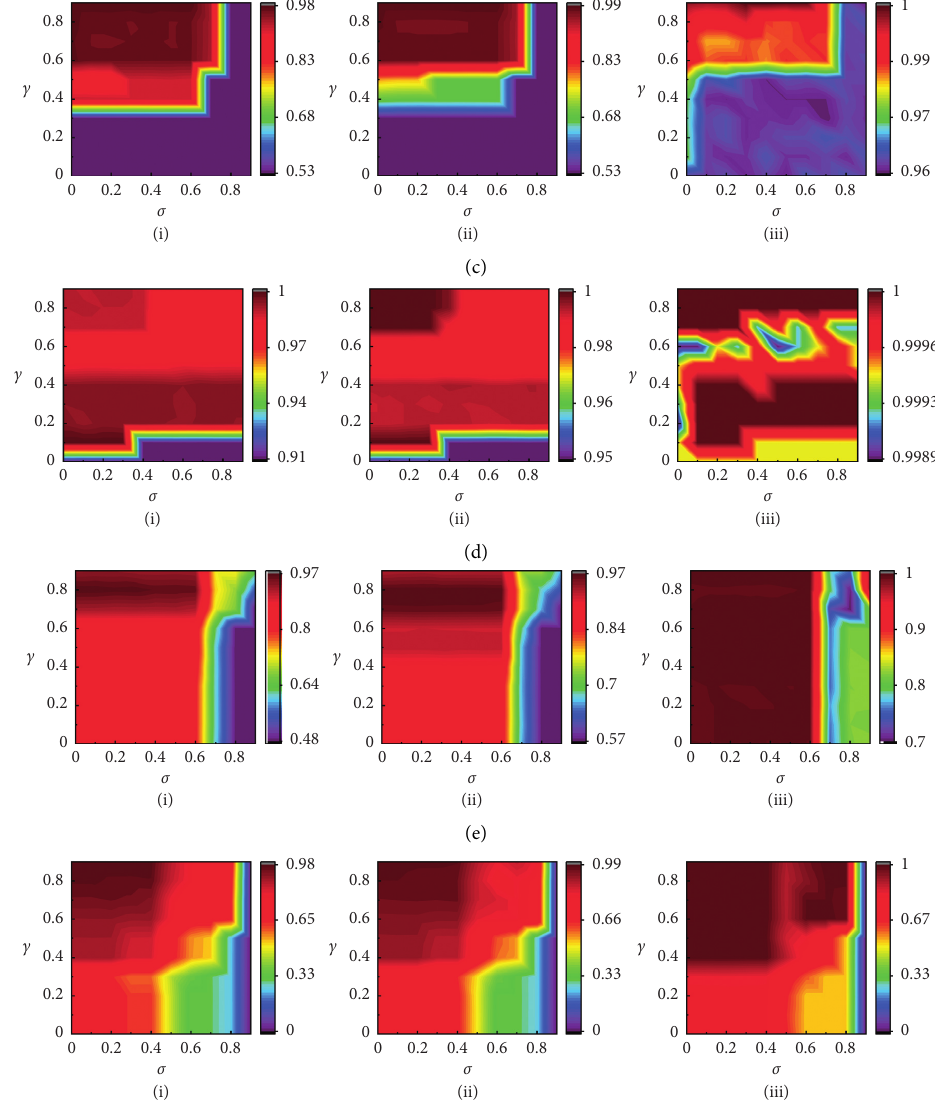
Figure 7: Results of the sensitivity analysis experiment. (a)–(f) represent experiments 1 to 6 with (i) LR, (ii) SVM, and (iii)